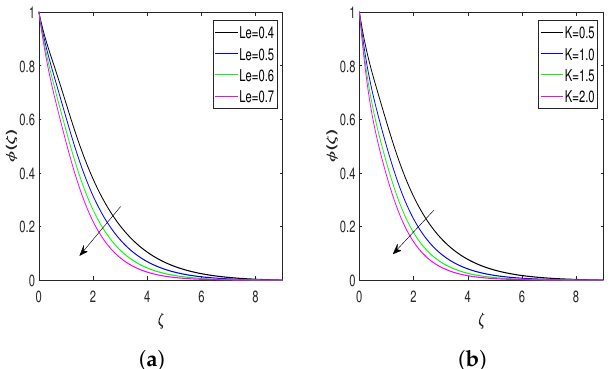
Figure 6. Nondimensional concentration profiles for flow parameters. ( a ) Concentration profile against Le and ( b ) concentration profile against K